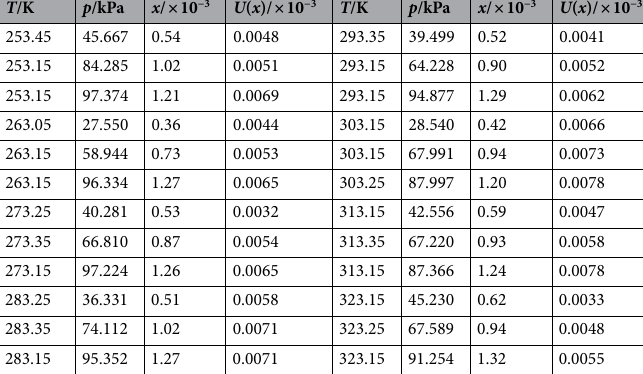
Table 4. Solubility (mole fraction) and associated uncertainty of O 2 in